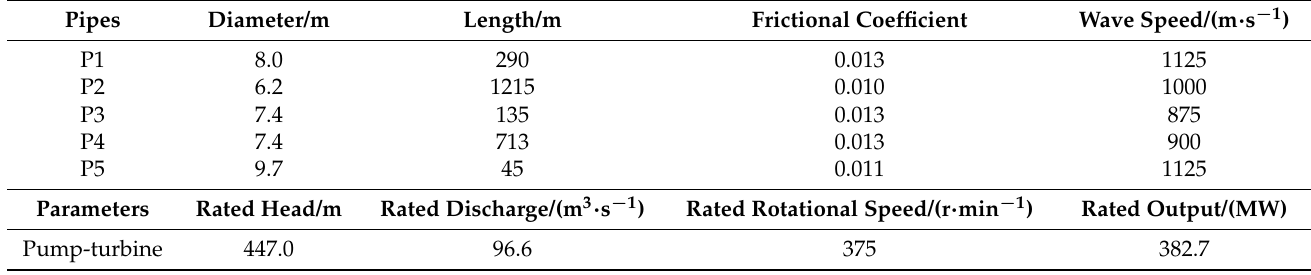
Figure 8. Complete characteristics of the pump-turbine: ( a ) 𝑛 1′ - 𝑄 1′ curves. ( b ) 𝑛 1′ - 𝑀 1 ′ curves. Table 4. Pipe and pump-turbine design parameters.